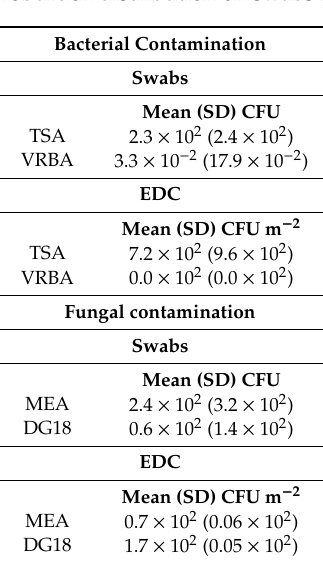
Table 4. Bioburden distribution on swabs and